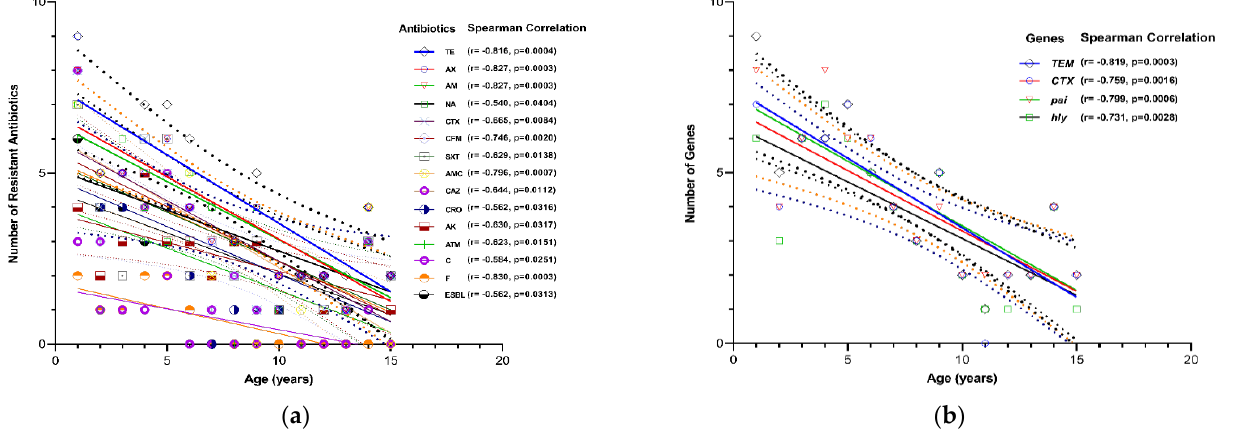
Figure 4. Correlation analysis between the children of all ages and antibiotic resistance to ( a ) and both the marker genes of ESBL-producing and virulence factors ( b ) of UPEC infection. This figure depicts the relationship between the antibiotic resistance to UPEC and the age of the children, where antibiotic resistance and gene markers for UPEC are illustrated in number terms. Each marker denotes a specific observation for antibiotics resistance and the age (years) of a particular child. This figure depicts the relationship between the UTIs with UPEC and the age of children, where UTIs are illustrated in number terms. Spearman’s correlation was performed by GraphPad Prism and a significance was considered to be established when p > 0.05. Spearman’s correlation method was carried out by GraphPad Prism, and significance was considered to be established when p > 0.05.